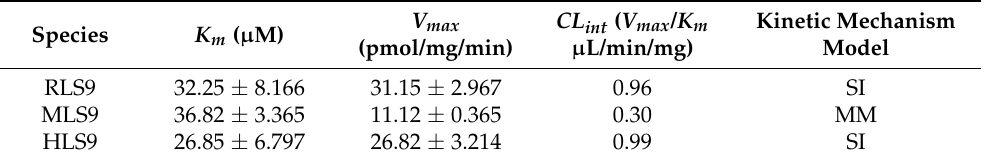
Table 2. Kinetic parameters derived for magnolol sulfation in liver S9 fractions from different species. Data represents the mean ± standard deviation of three determinations. SI stands for the substrate inhibition model.